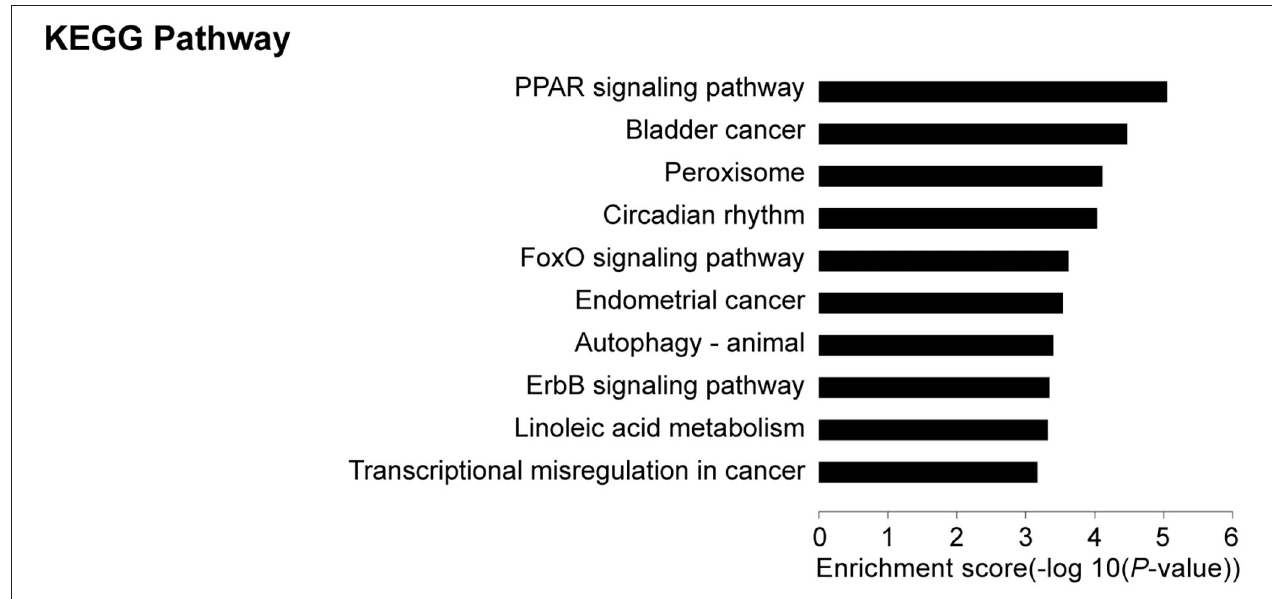
FIGURE 4 | Results of KEGG analysis: Top 10 KEGG pathways in IUGR compared with AGA.